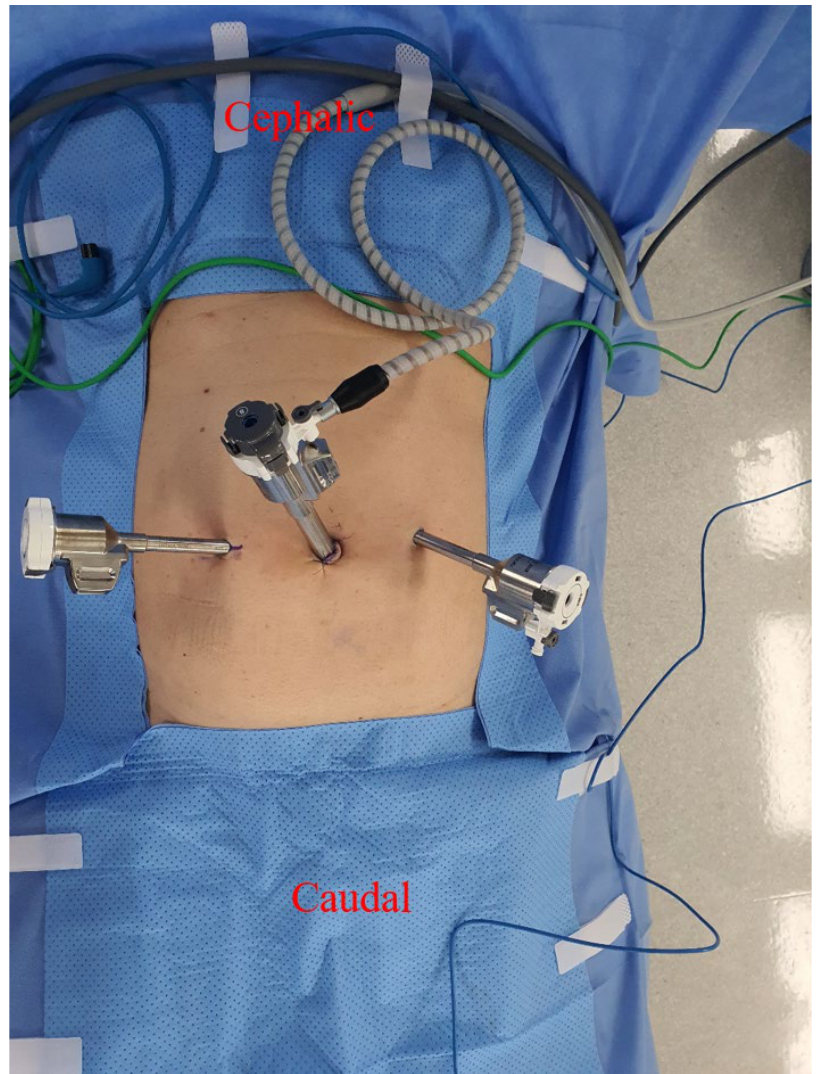
Figure 1. Robotic-assisted TAPP inguinal hernia surgery trocar placement.